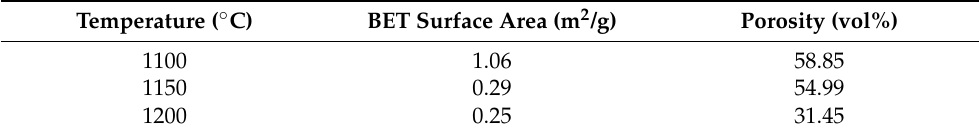
Table 2. BET surface area and porosity of different sintering temperatures for C 1 A.